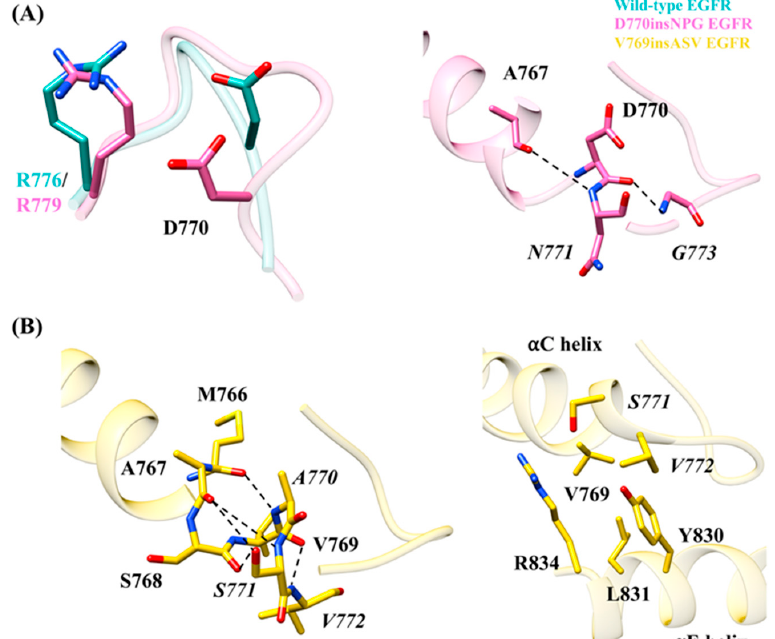
Figure 6. Interactions observed at the mutation sites and indicated on the starting EGFR structures. These interactions were observed during MDS. A) D770insNPG EGFR and B) V769insASV EGFR. ( A ) Placement of Arg776 (wild type)/Arg779 (mutant) and Asp770 (left) and comparison with wild-type EGFR. In D770insNPG EGFR, due to the insertions, Asp770 is positioned slightly closer to Arg779 of the α C- β 4 loop. Interactions (right, dotted lines) crucial for stabilizing the β -turn formed by the inserted residues in D770insNPG EGFR. ( B ) Hydrogen bonding interactions (left, dotted lines) observed maintaining the additional helix turn formed by the V769insASV insertion at the C-terminus of the α C helix. Amino acids (right) that are integral for the interaction between the C-terminus of the α C helix and the α E helix in V769insASV EGFR.